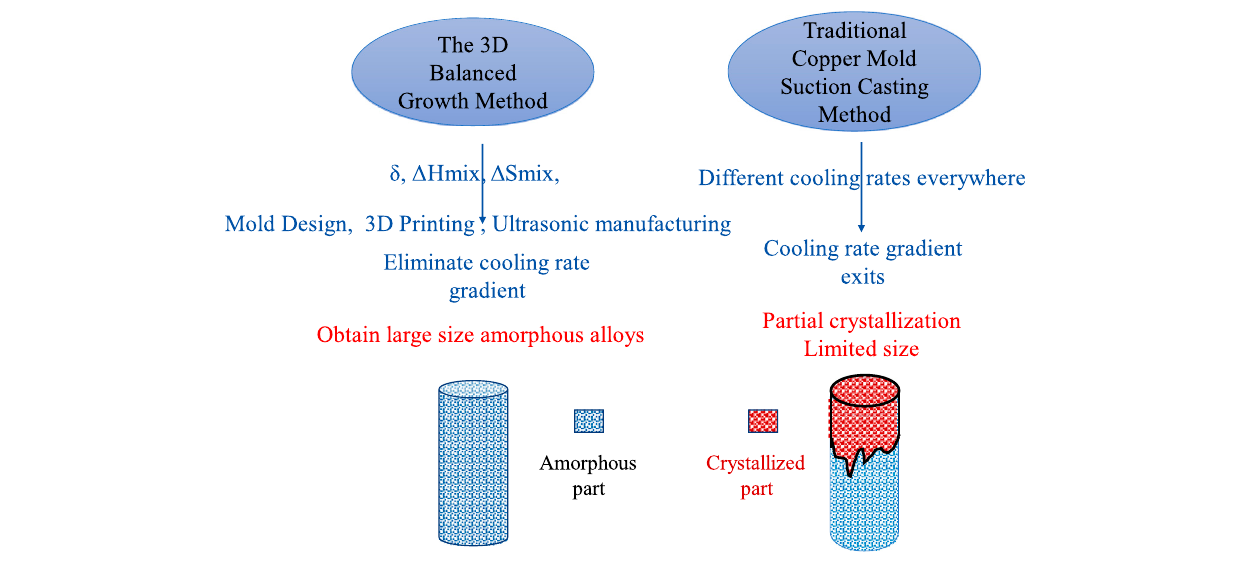
Frontiers in Materials |